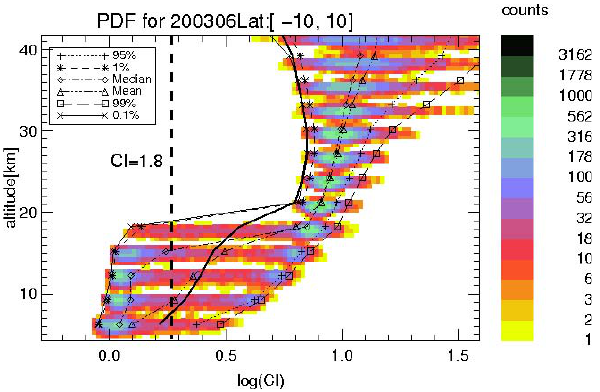
Fig. 2. The probability density distribution of log 10 ( CI A ) for MI- PAS measurements in June 2003 in the equator region ( ± 10deg latitude). Superimposed on a 3km vertical grid various percentiles (0.1, 1, 50 (median), 95, and 99%), a mean, and an optimised CI threshold profile (thick solid vertical line, details see text) as well as the constant threshold of CI=1.8 (thick dashed line). Horizontal stripes are caused by the accurate pointing of the nominal tangent height (3km altitude grid with minimum heights around